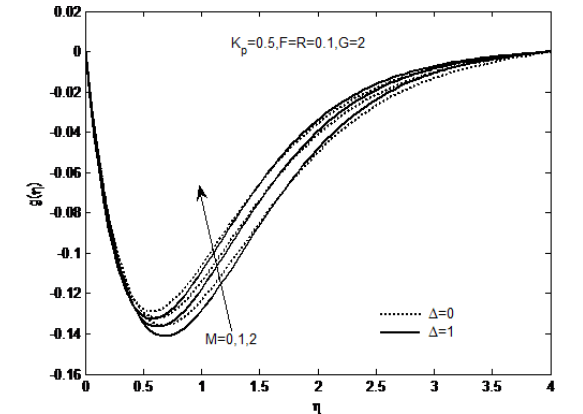
Fig. 5: Angular velocity profile for different values of M and ∆